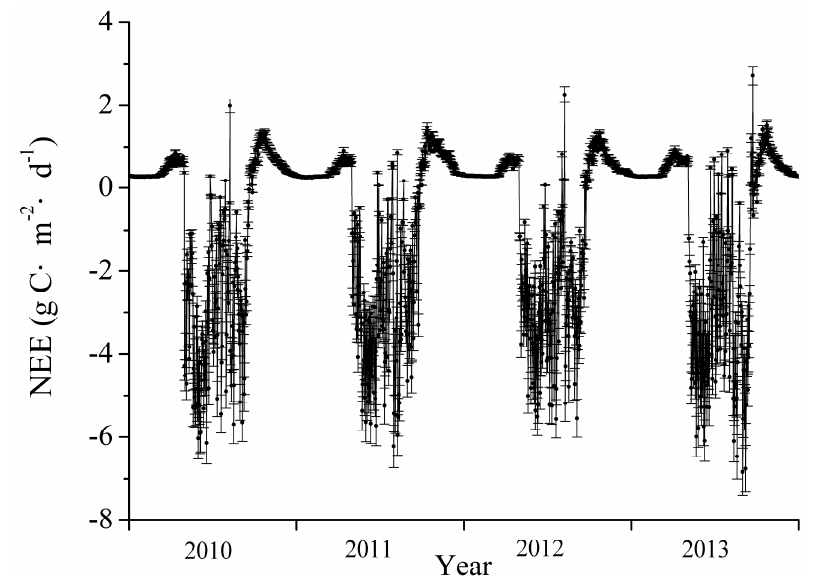
Figure 6. Eddy covariance measurements of NEE in the L. principis-rupprechtii forest. Data are daily mean NEE during 2010–2013. Error bars are based on 0.5 h eddy covariance measurements of NEE as experimental unit ( n = 48).